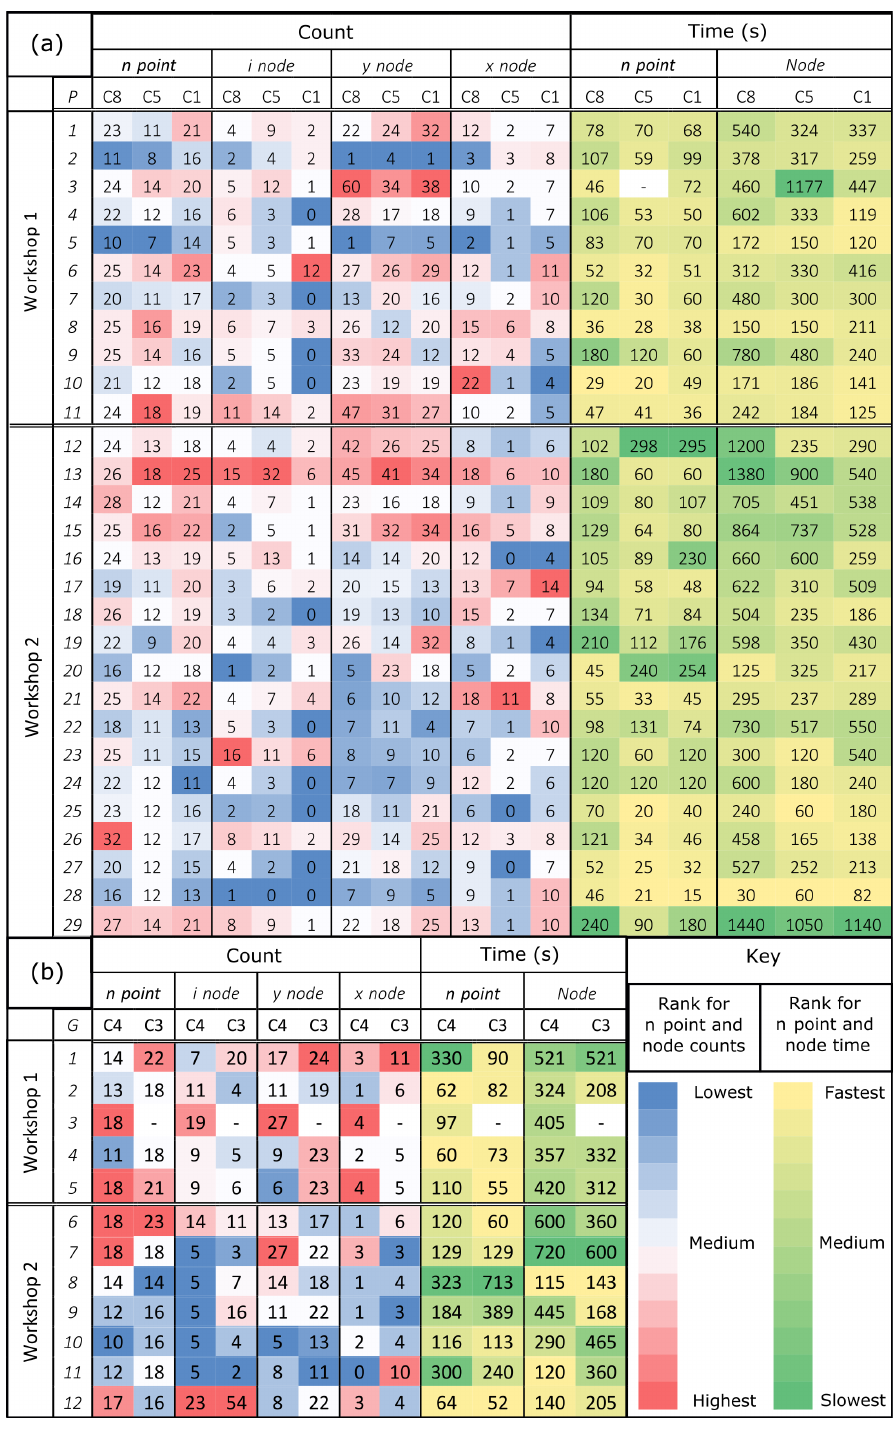
Figure 4. Recorded fracture data ( n and node counts) and the time taken to complete n and node counts for workshop (WS) participants (P) and groups (G). The data for each attribute have been colour-coded according to where the reported value for the parameter ranked for that circle. Data are presented in the order that they were completed in the